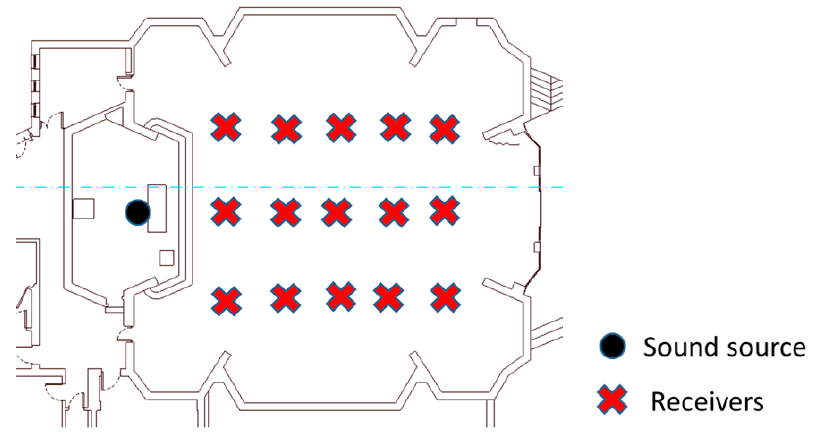
Figure 3. Ground plan with the position of source and of the measurement points.